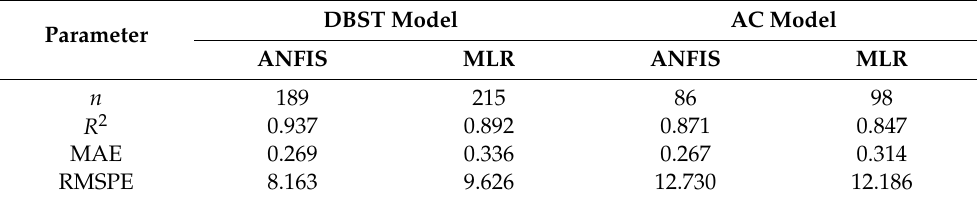
Table 6. Comparison of the goodness of fit statistics for the ANFIS and the MLR models.